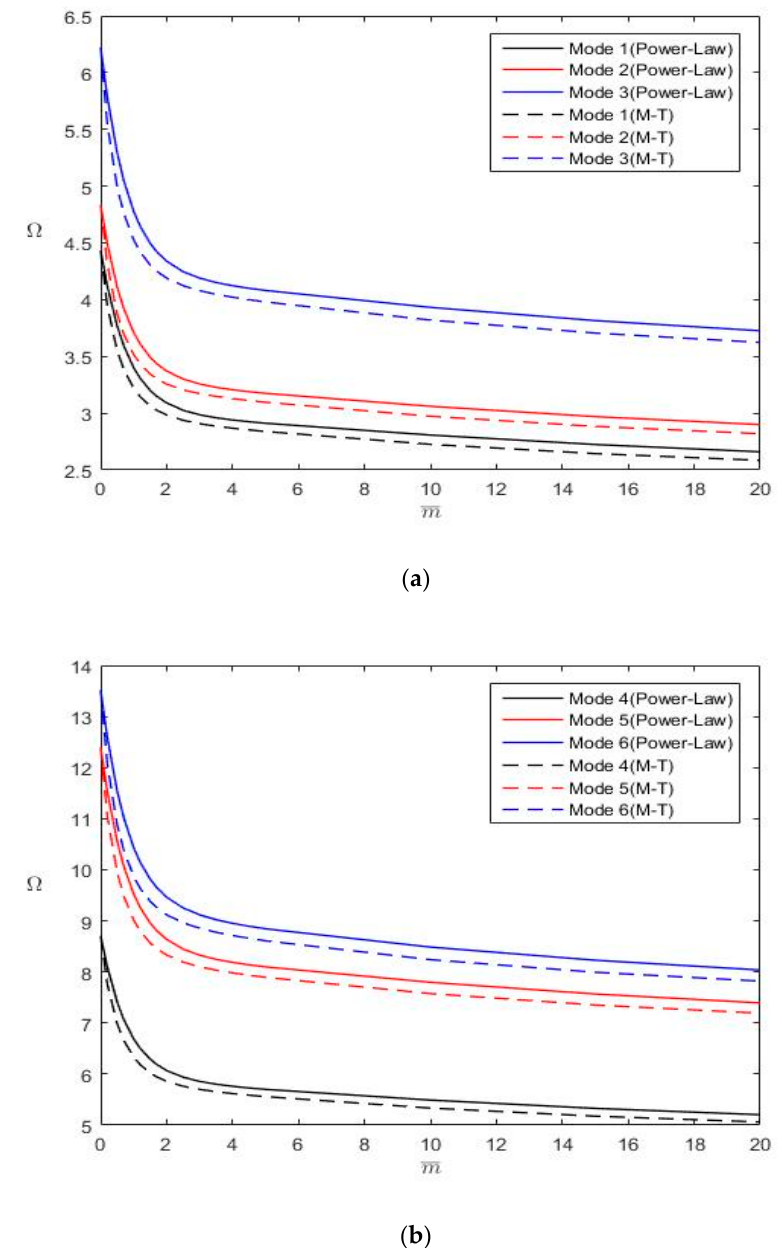
Figure 5. Variations of Ω with m for a CFSF FGM rectangular plate (b / a = 2, h / a = 0.1) : ( a ) for modes 1–3; ( b ) for modes